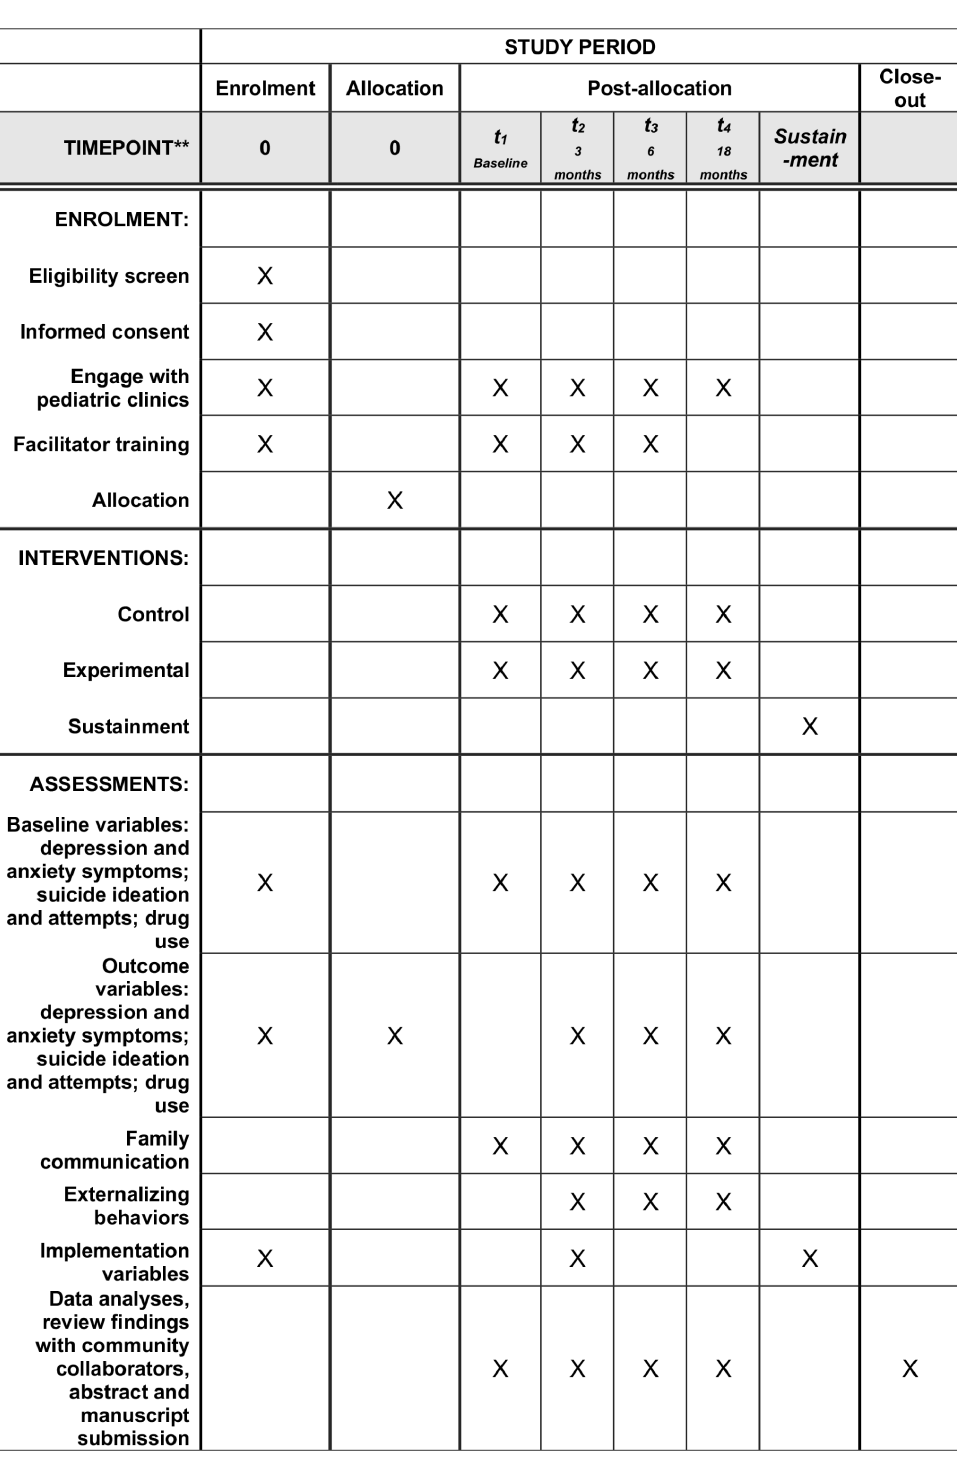
Fig 1. Schedule of enrolment, intervention, and assessments.